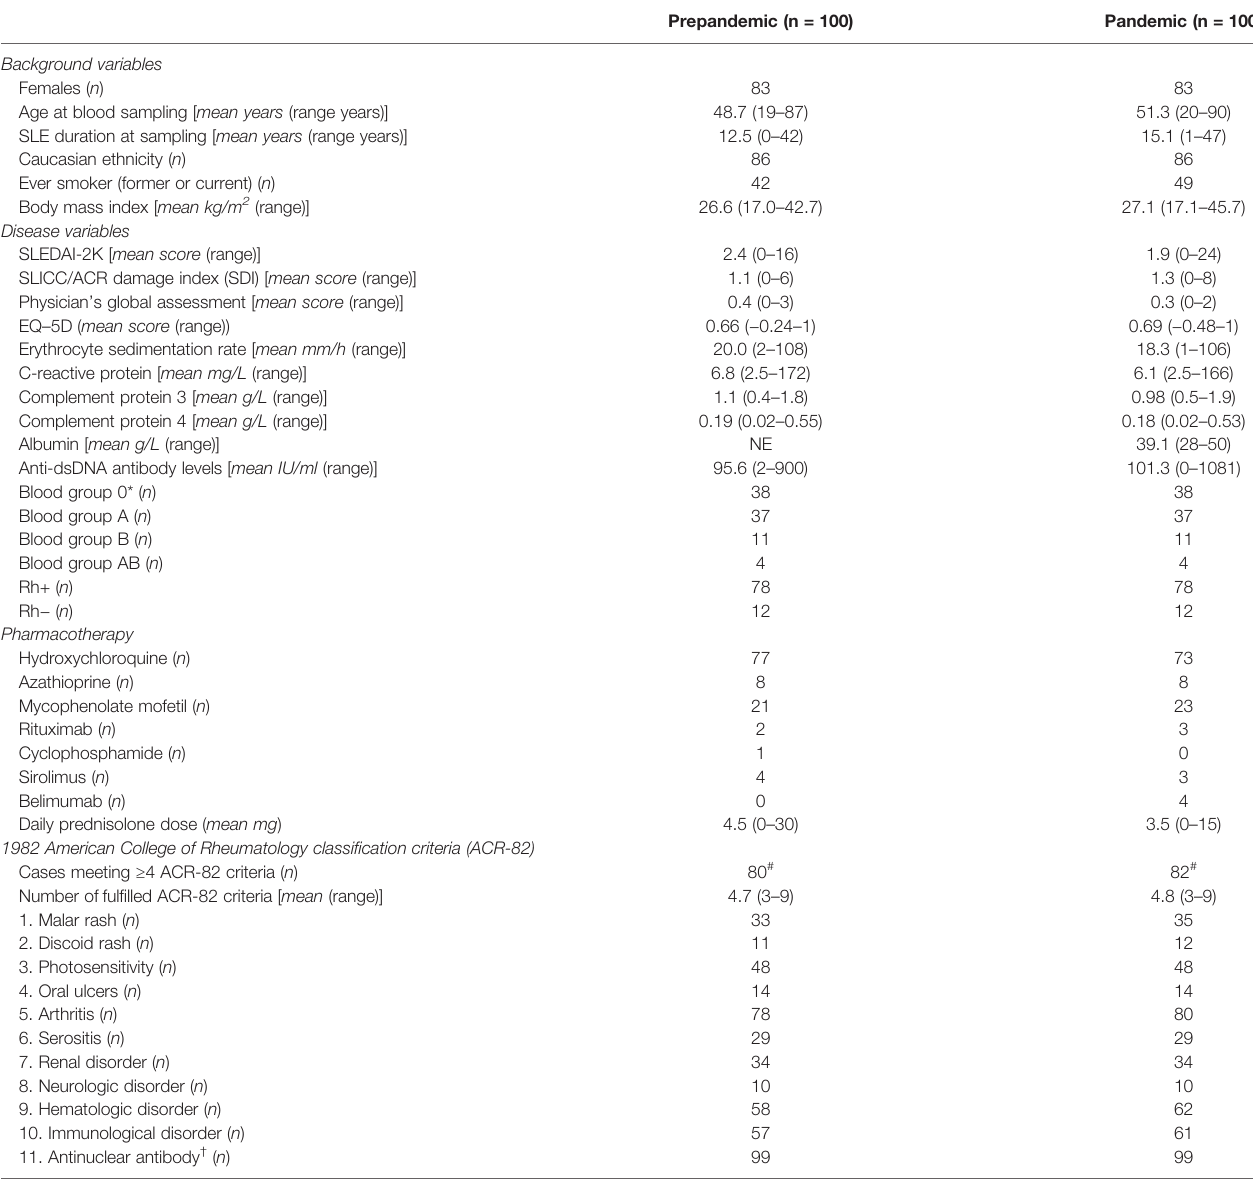
TABLE 1 | Characteristics of the 100 included patients with